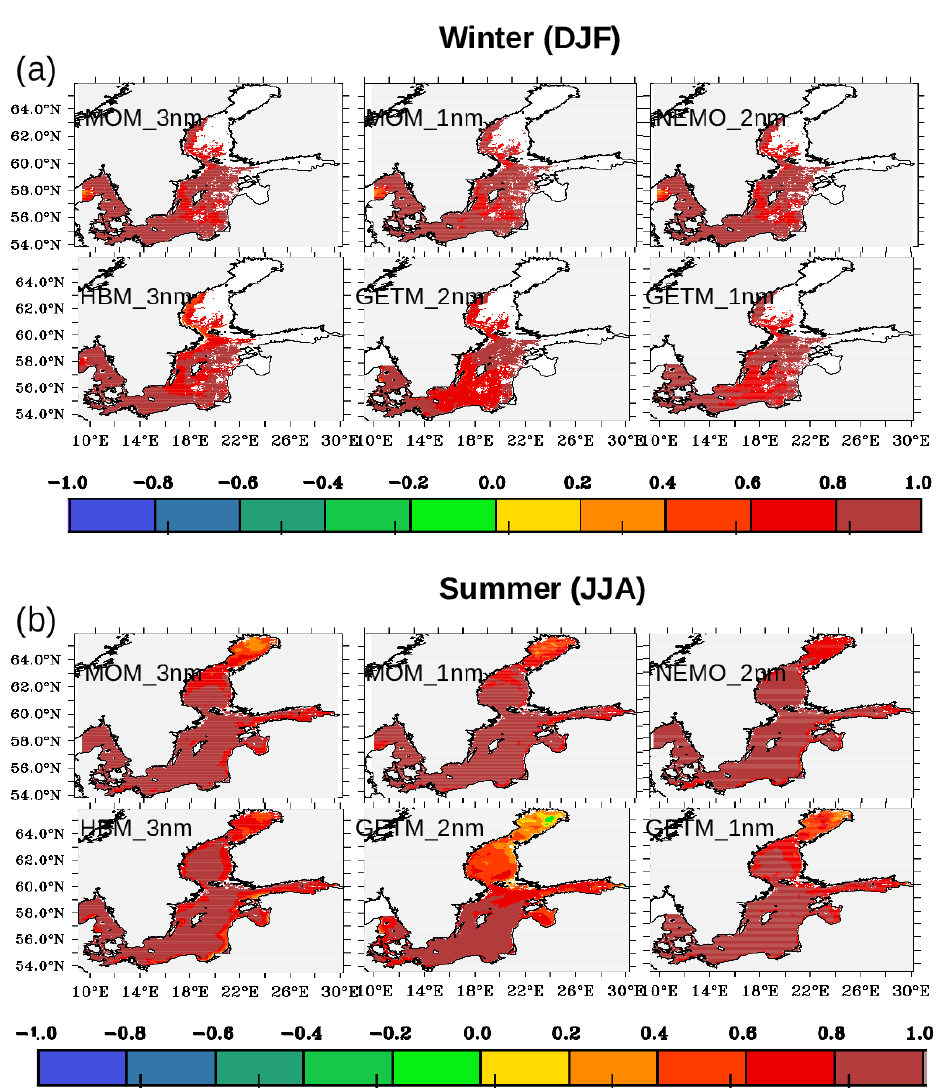
Figure 4. (a) Correlation of interannual winter sea surface temperature variation between models and the satellite product. (b) Correlation of interannual winter sea surface temperature variation between models and the satellite